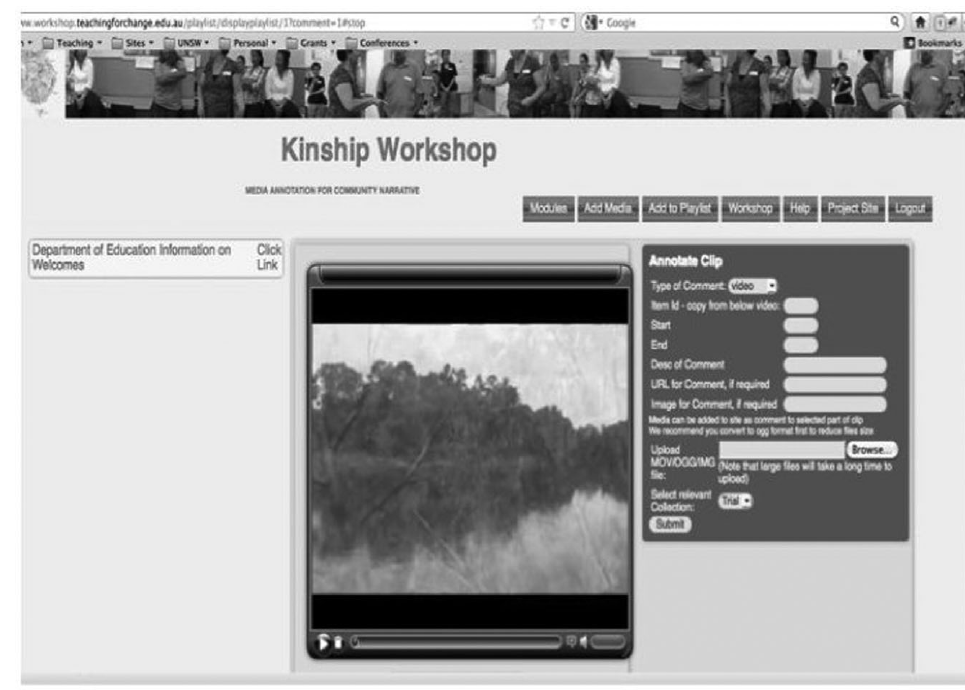
Annotation interface for editors showing previously added comments on left.